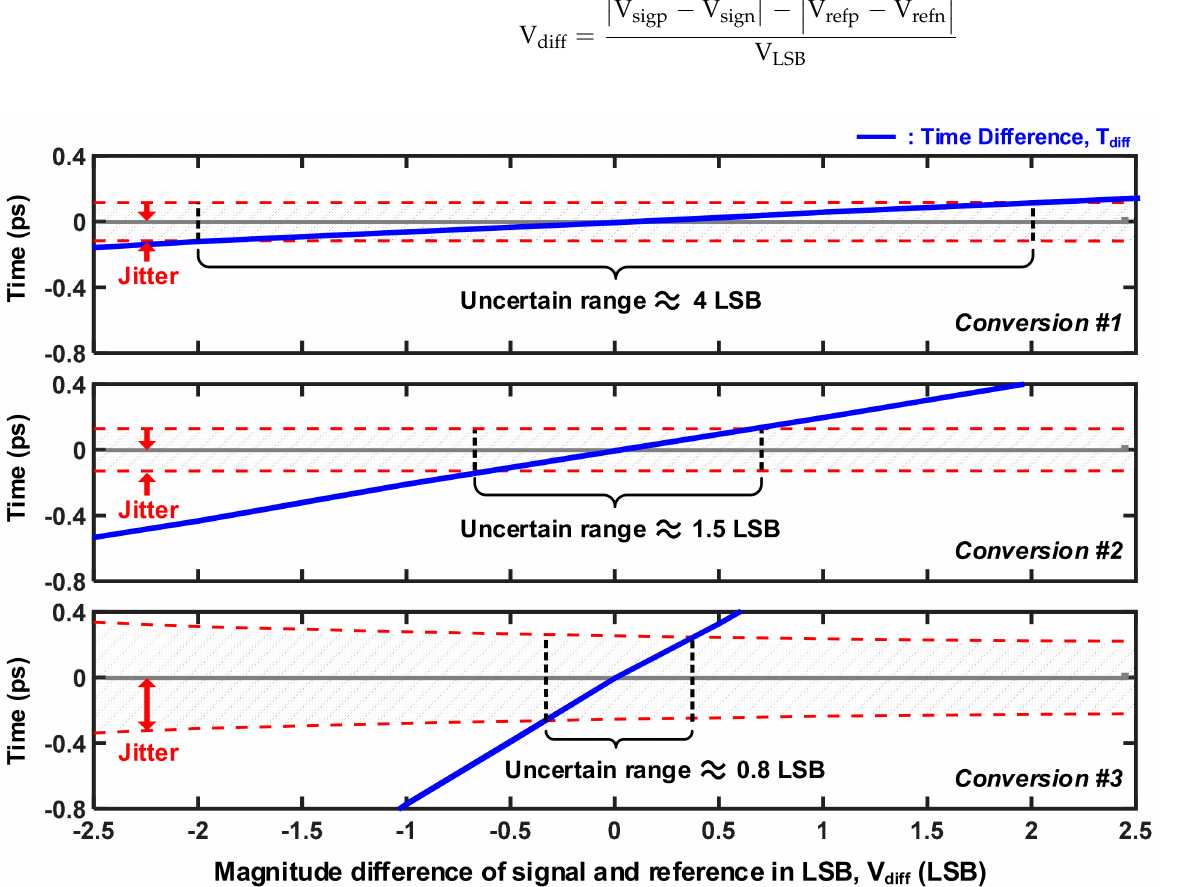
Figure 8. Simulated decision time difference versus normalized voltage difference and uncertain range. The uncertain range is confined by the region where jitter noise is larger than |T diff